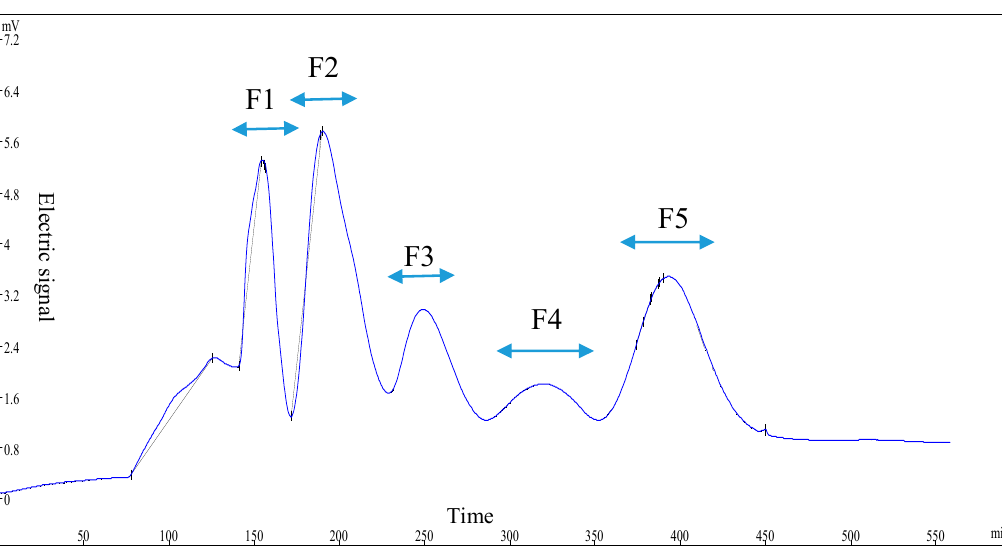
Figure 1. Gel permeation chromatography (GPC) chromatogram ( λ = 220 nm) of fraction U- II .